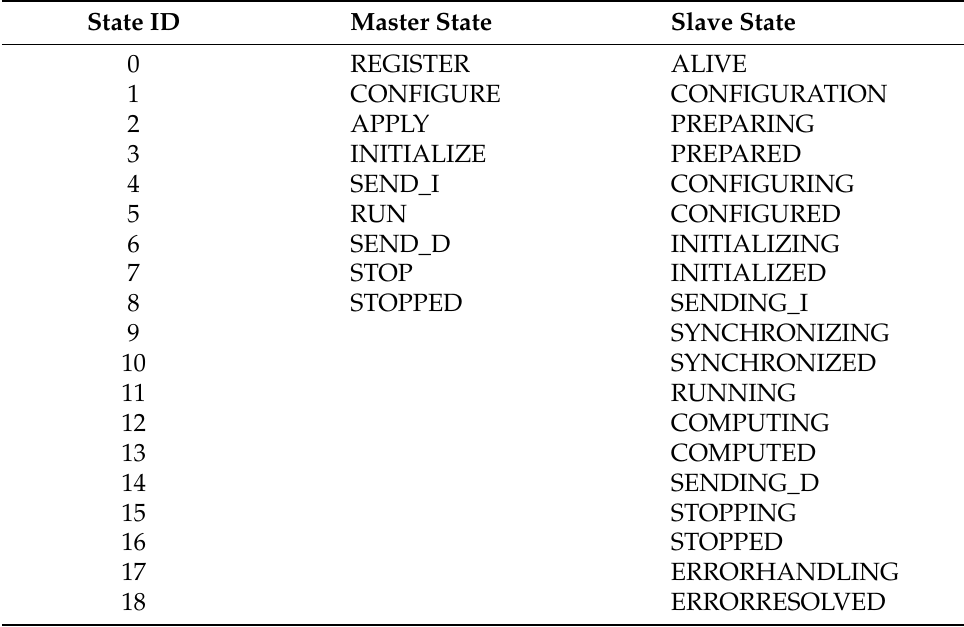
Figure 7. Example of DCP state machine functionality. Table 7. DCP state IDs and related states for master and